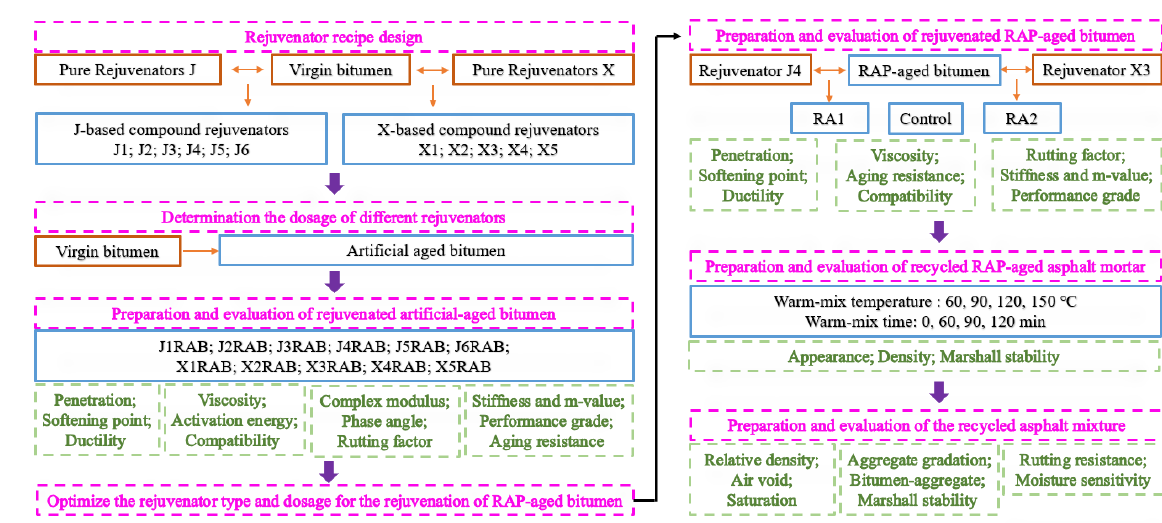
Figure 1. The research protocol of this study.